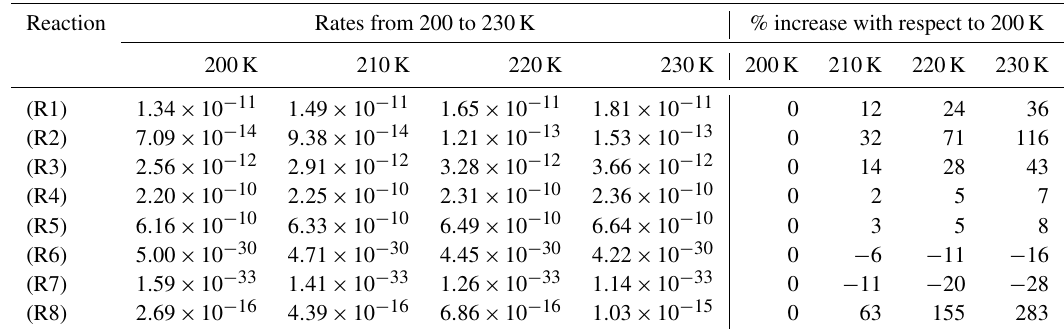
Table 3. Values of the reaction rates and their percentage increases for temperatures from 200 to 230K (units of the reaction rates are given in the respective rate expressions) Reaction Rates from 200 to 230K % increase with respect to 200K 200K 210K 220K 230K 200K